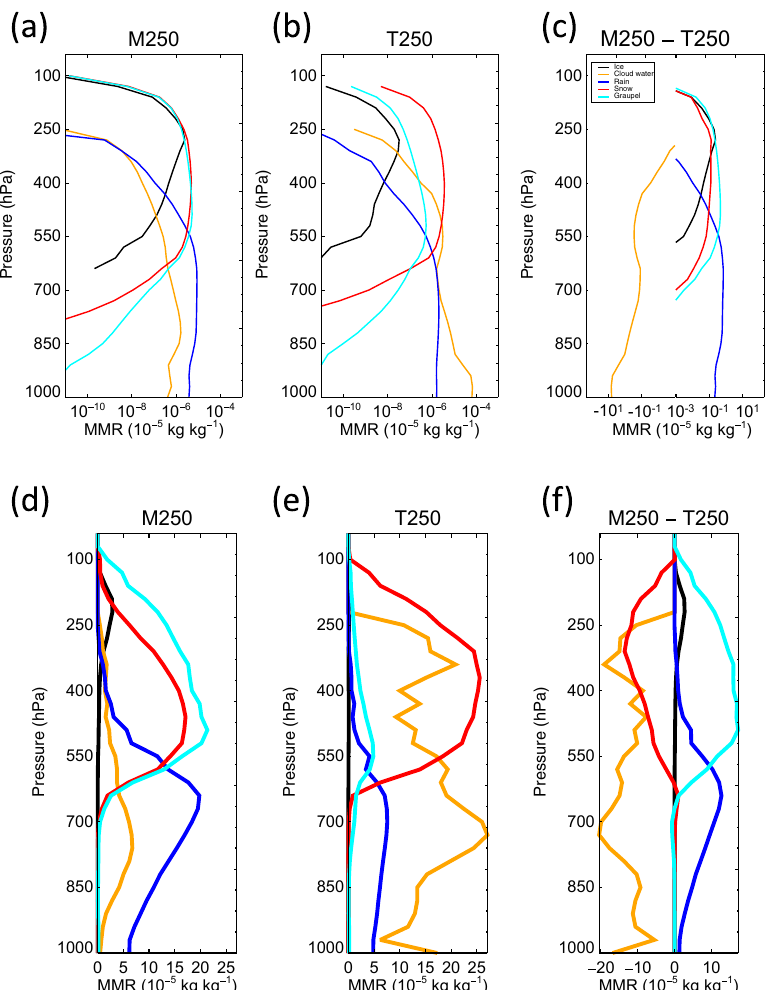
Figure 6. Congo case: mean vertical profiles of hydrometeor mass mixing ratios (MMRs) averaged over the period 1–10 August 2007. (a) CONGO-M250 cloudy column domain mean, (b) CONGO-T250 domain mean, (c) the difference in the domain-mean hydrometeor mixing ratio profiles (CONGO-M250 minus CONGO-T250), (d) CONGO-M250 mean over condensed points only, (e) CONGO-T250 mean over condensed points only for each hydrometeor class and (f) the difference in the condensate-mean hydrometeor mixing ratio profiles (CONGO-M250 minus CONGO-T250). Note the logarithmic horizontal axis used in panels ( a–c ) due to the total difference between the hydrometeor classes simulated by the two schemes spanning several orders of